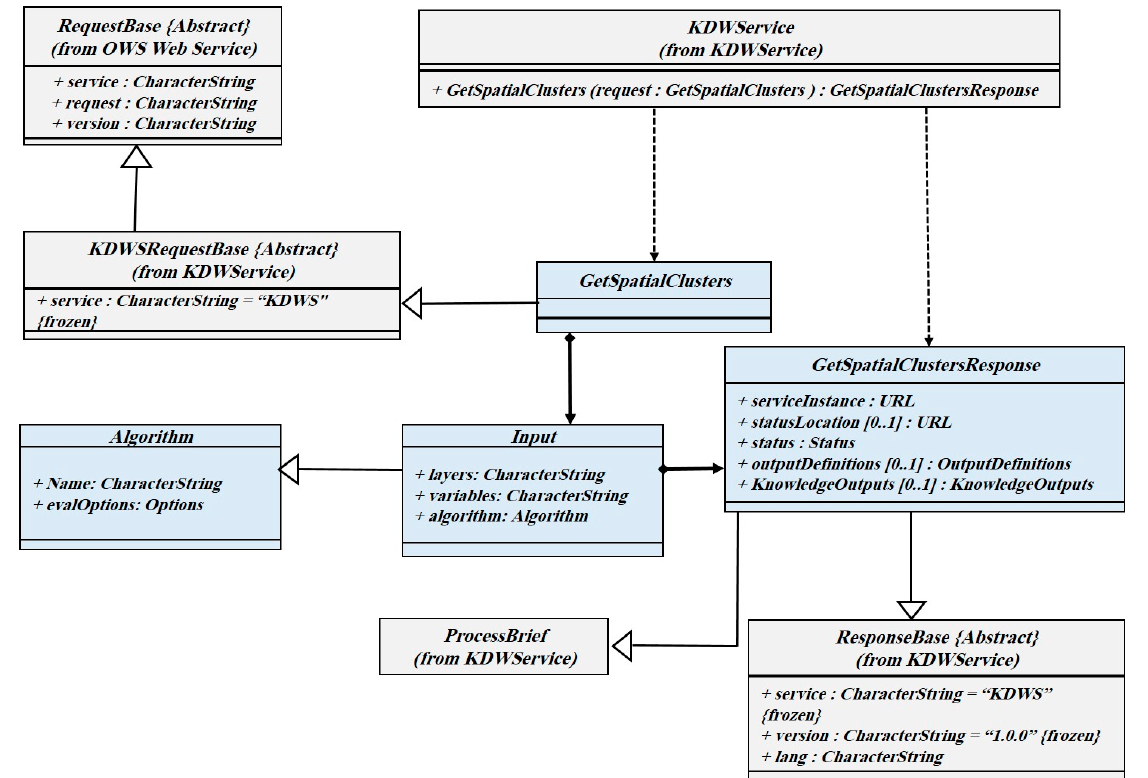
Figure 6. The interface of the GetSpatialClusters operation.